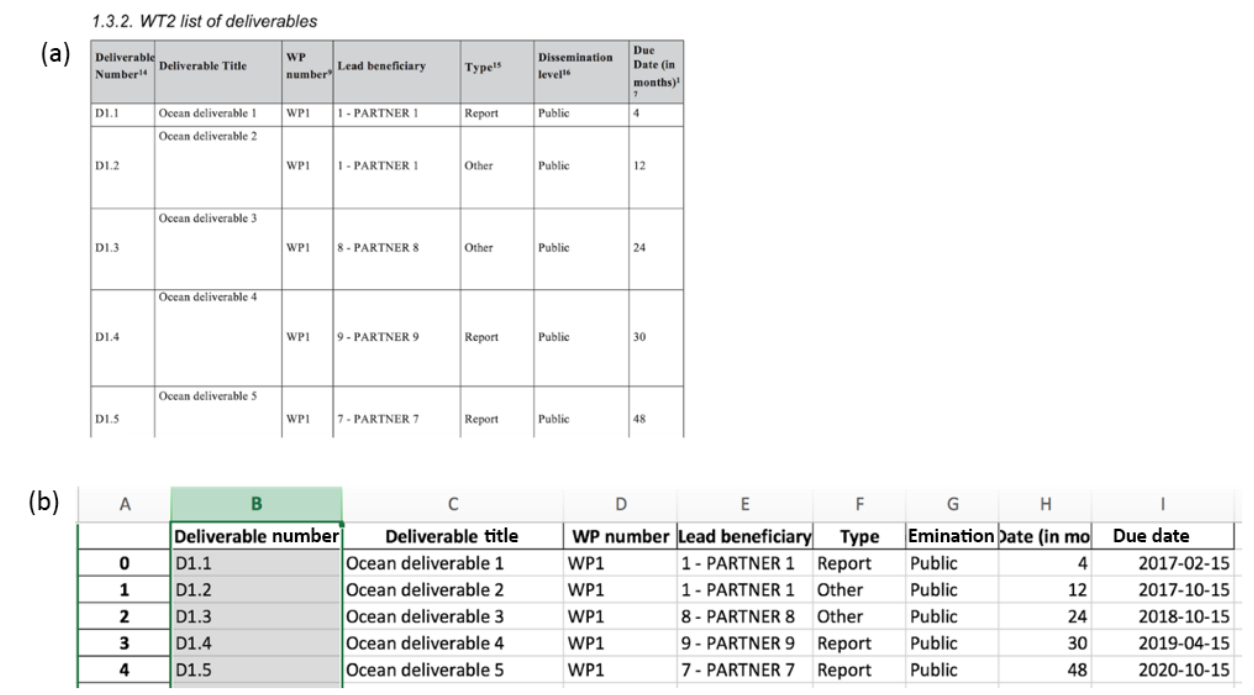
Figure 1. The “list of deliverables” table from standard EU Horizon 2020 DoW document (a) , and data automatically extracted from this document and saved to MS Excel spreadsheet (b)